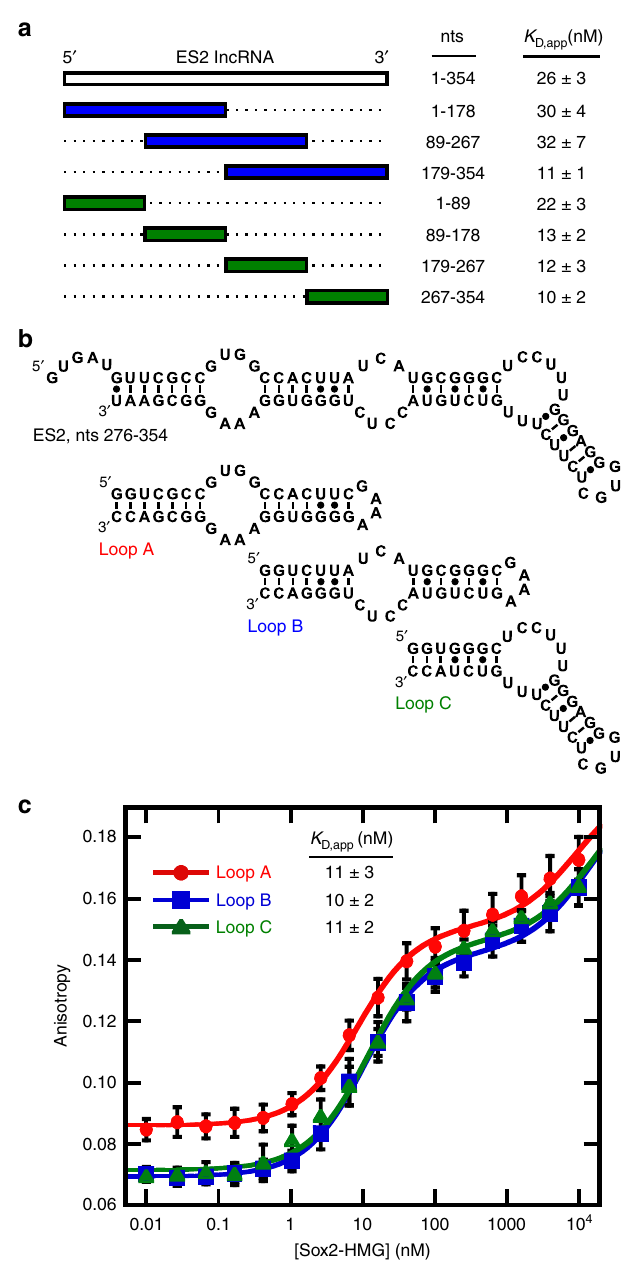
Fig. 2 Deletion analysis of the ES2 lncRNA. a Schematized depiction of the ES2 lncRNA and the segmented transcripts. Apparent binding af fi nity displayed as the average and s.e.m. of n = 6 technical replicates excluding 1 – 354 ES2, which is n = 10 technical replicates). b Sfold 44 predicted secondary structure of ES2 , nts 276 – 354, and minimized loop constructs. c Average binding curve for each Sox2-RNA interaction with error bars displaying the standard deviation of each measurements. K D,app is reported for the fi rst transition and presented as the average and the s.e.m. of n = 6 technical